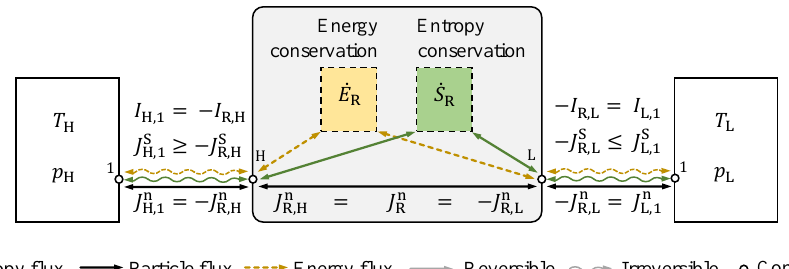
Figure 8. Schematics of the ES -regenerator model exchanging working gas with two adjacent gas reservoirs. Inside the regenerator, energy and entropy are balanced and stored independently according to Equations (29) and (30), as depicted by the yellow and green dashed boxes representing bookkeeping containers. The temperatures at the regenerator’s contact points H and L are determined by the current energy and entropy content via Equations (25) and (26), respectively. These contact point temperatures influence the fluxes of energy and entropy that the regenerator exchanges with the adjacent gas reservoirs and, thus, feed back to its dynamics (Equations (29) and